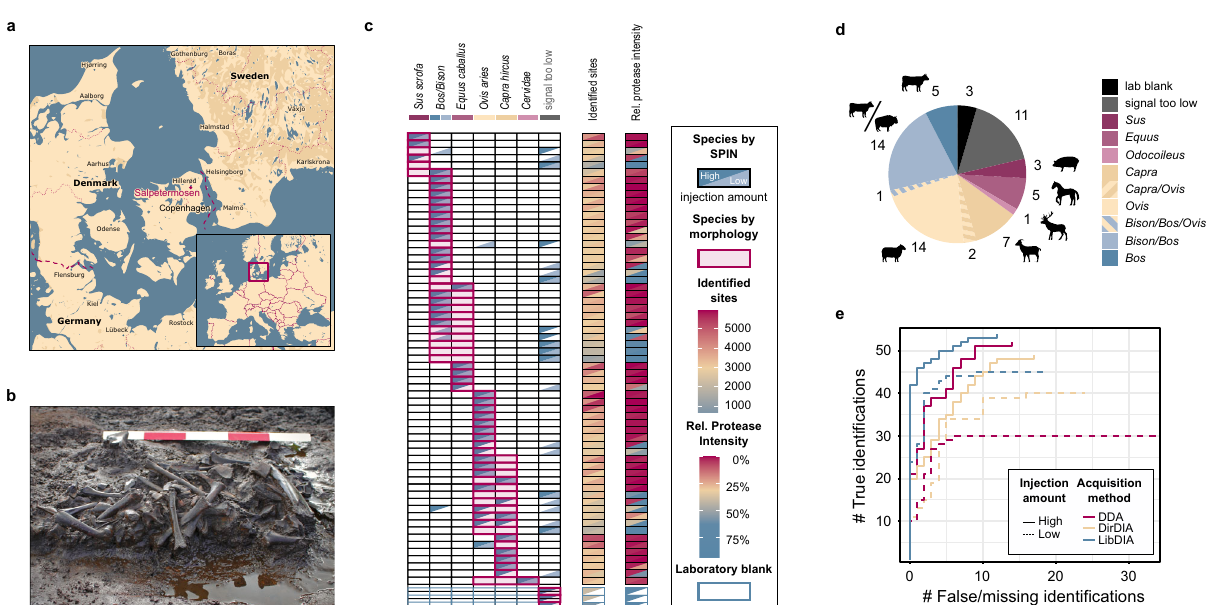
Fig. 4 Species identi fi cation of bones from the Scandinavian Iron-Age. a Location of the archaeological site “ Salpetermosen Syd 10 ” on Zealand in Denmark in the Hillerød municipality 30 km north of Copenhagen. Map drawn in Mapbox Studio using a custom style. b Cross section of an in situ wetland bone deposit. Scale bar is 50 cm. Four bones were radiocarbon dated between 1720 and 1570 BP. Picture provided by the Museum of North Zealand. c Species identi fi cation results by SPIN (5 min method, library-based DIA) and by morphological assessment for 63 samples from the Salpetermosen site measured in technical duplicates and 3 blanks. Rows represent individual samples and have been ordered fi rst by morphological species assignment and then by decreasing mean site coverage. The upper left and lower right wedge of each cell represent results measured in two separate experiments, one with higher (upper left, dark blue) and the other with lower (lower right, light blue) MS signal intensity. The fi rst seven columns indicate SPIN species by blue wedges and morphological species possibilities by pink boxes. Bovine species assignments are combined in column two. The eighth and ninth columns are heatmaps showing the absolute number of covered amino acids and relative protease intensity, respectively. d Summary of SPIN species identi fi cations from panel c in the replicate with high MS intensity. Bovine identi fi cations are separated into cow ( Bos ) and broader bovine identi fi cations ( Bos/Bison ). Striped colors indicate samples with insuf fi cient sequence coverage to distinguish closely related taxa. Samples with insuf fi cient sequence coverage for con fi dent species identi fi cation are marked as “ signal too low ” and correctly excluded blanks are marked in black. e Pseudo receiver operating characteristic (ROC) curves for comparing the sensitivity and success rate of three different data acquisition and analysis strategies. Results of each dataset were sorted by decreasing number of identi fi ed sites. The y -axis shows the cumulative number of correct species identi fi cations in agreement with the morphology. The x -axis shows the cumulative number of false or missing identi fi cations below the relative protease intensity threshold. Color indicates data acquisition and analysis mode with pink for DDA, dark blue for library-based DIA, and sand color for library-free DirectDIA. Experiments with lower MS intensity are shown by dashed and high intensity by solid